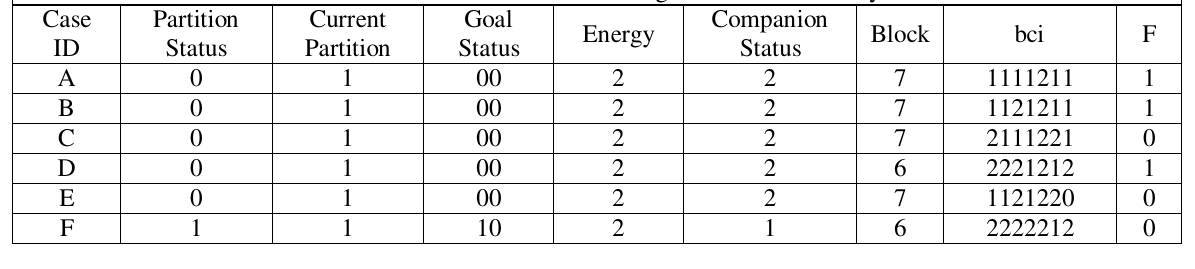
Table 8: States Status of Leader Agent after MDP Policy